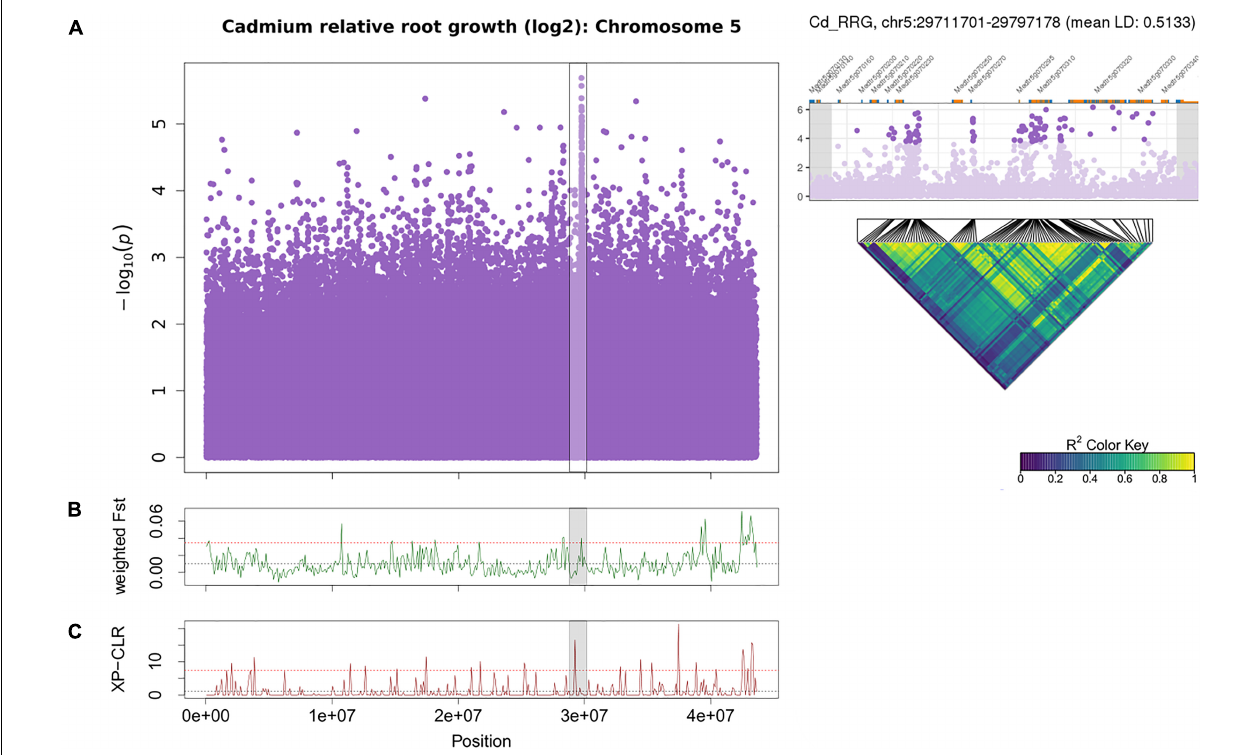
FIGURE 5 | Manhattan plot of Cd relative root growth (RRG) associations for chromosome 5 using GAPIT (A) . The region on chromosome 5 associated with Cd RRG contained MtCAX3 (Medtr5g070330), MtPDR3 (Medtr5g070320), MtCPT7 (Medtr5g070270) and MtDDB2 (Medtr5g070310). The SNPs in genic and intergenic regions are in high LD (pairwise linkage disequilibrium (LD) among the 100 most significant SNPs in the peak). Each point represents a SNP, the x-axis signifies the position on the chromosome while the y -axis is the –log 10 of the p -value. The Cd RRG phenotype was log 2 transformed to normalize the data prior to running the GWAS. The GWAS region is highlighted in gray the F st (B) and XP-CLR (C) sliding window (100 kb windows) analyses. The x -axis represents the chromosomal position, the y -axis the F st or XP-CLR-value of the window at the corresponding position. Higher F st indicates population differentiation, higher XP-CLR indicates the presence of a selective sweep. The dashed black line represents the mean F st or CLR-values for the chromosome, the dashed red line represents windows ≥ 5% of the highest F st or CLR-values for the